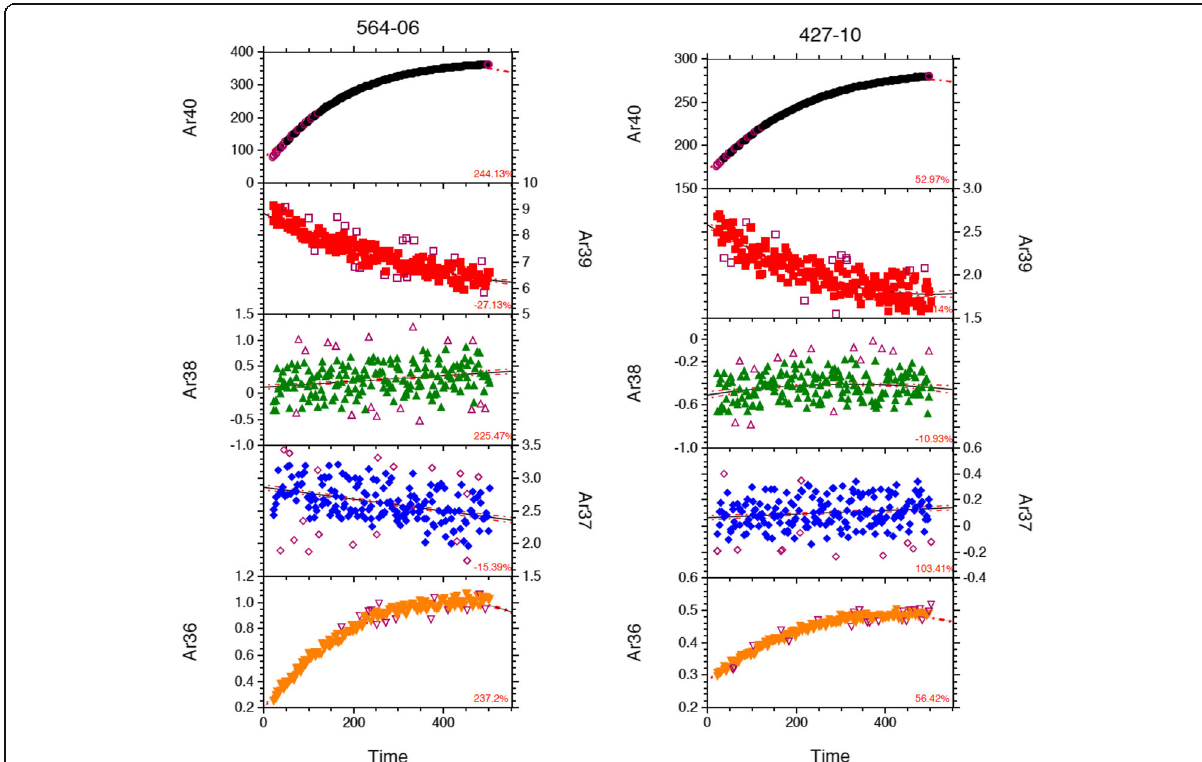
Fig. 2 Examples of the peak suppression effect in 40 Ar and 36 Ar signals for volatile-rich samples: (left) basaltic rock, (right) alunite. Note that the 40 Ar and 36 Ar signals gradually increased during the measurement, so that it is not possible to deduce meaningful zero-time